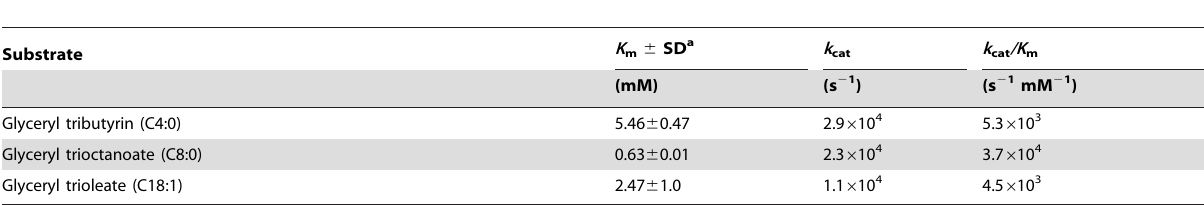
Table 1. Kinetic parameters of recombinant LipIAF5-2 toward short chain triglycerides.